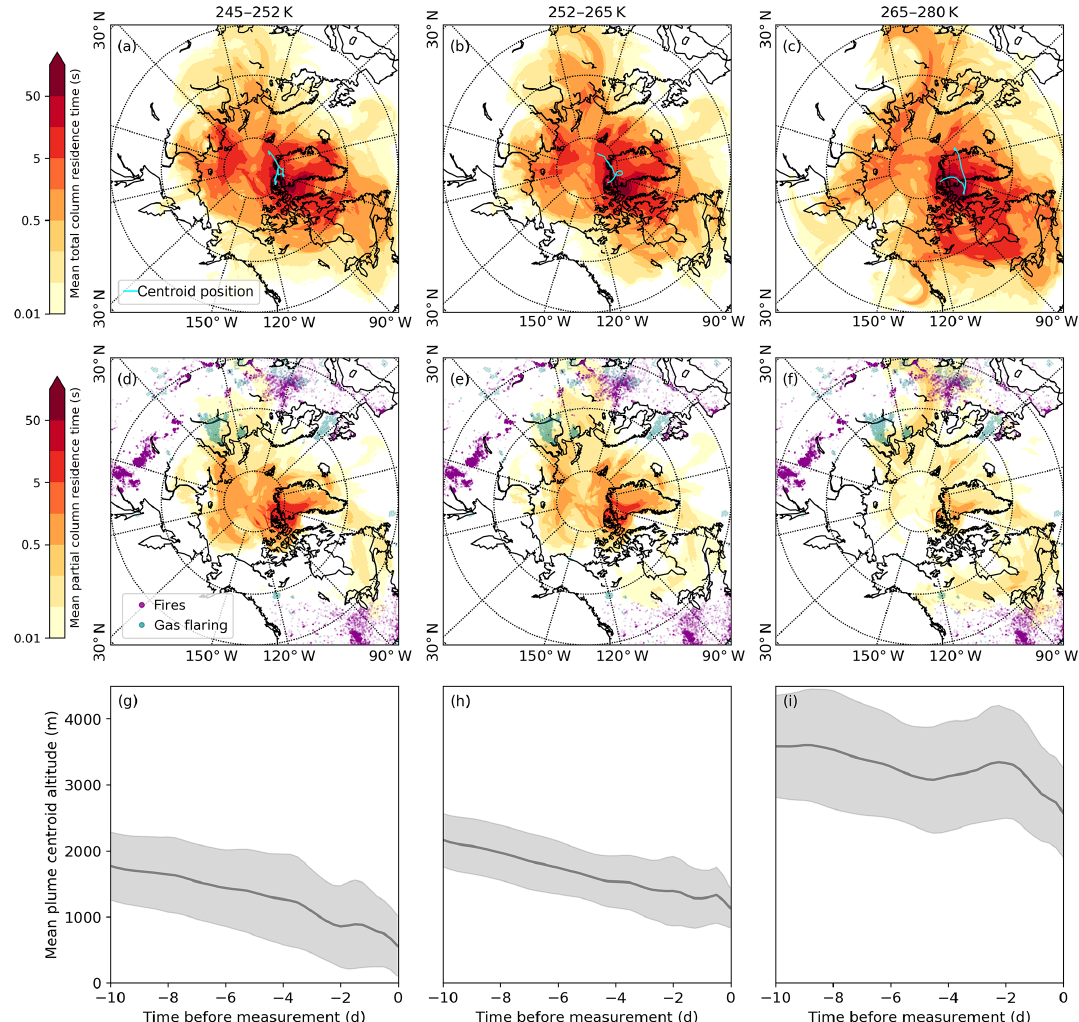
Figure 3. FLEXPART-ECMWF potential emission sensitivity (PES) and plume centroid altitude averaged over three potential temperature ranges in the polar dome. (a–c) Mean total column PES, (d–f) mean partial column ( < 200m) PES, (g–i) mean plume centroid altitudes for 245–252K (a, d, g) , 252–265K (b, e, h) and 265–280K (c, f, i) . Fire locations during 28 March to 13 April 2015 from MODIS are purple points, gas flaring locations associated with oil and gas extraction from the ECLIPSE emission inventory (V5) for 2015 are light blue points. Parallels are shown in dashed circles at 45, 60 and 80 ◦